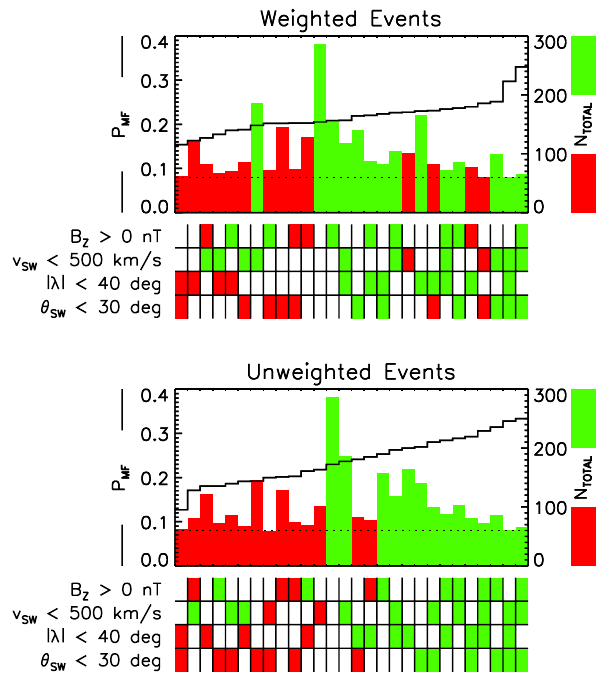
Fig. 4. Probability of occurrence of weighted (top panel) and un- weighted (bottom panel) MP oscillation events with the frequen- cies 0 . 7, 1 . 3, 1 . 9, 2 . 7 and 3 . 3mHz normalized to all MP oscilla- tion events within the frequency band 0 to 6mHz ( P MF , solid line, left axis). Below each diagram the corresponding criteria applied for event selection are shown: green indicates its application, red the application of the opposite criterion. If unconsidered the corre- sponding block is left white. Bars in the diagrams show the number of events selected (right axis). 60 has been chosen as lower limit (dotted line). Red bars indicate that one or more criteria have been applied in the opposite sense to the one